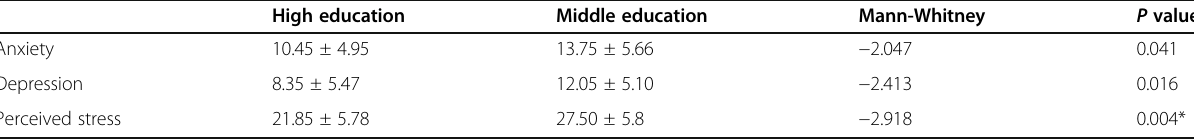
Table 3 Education level in relation to anxiety, depression, and perceived stress before weight reduction